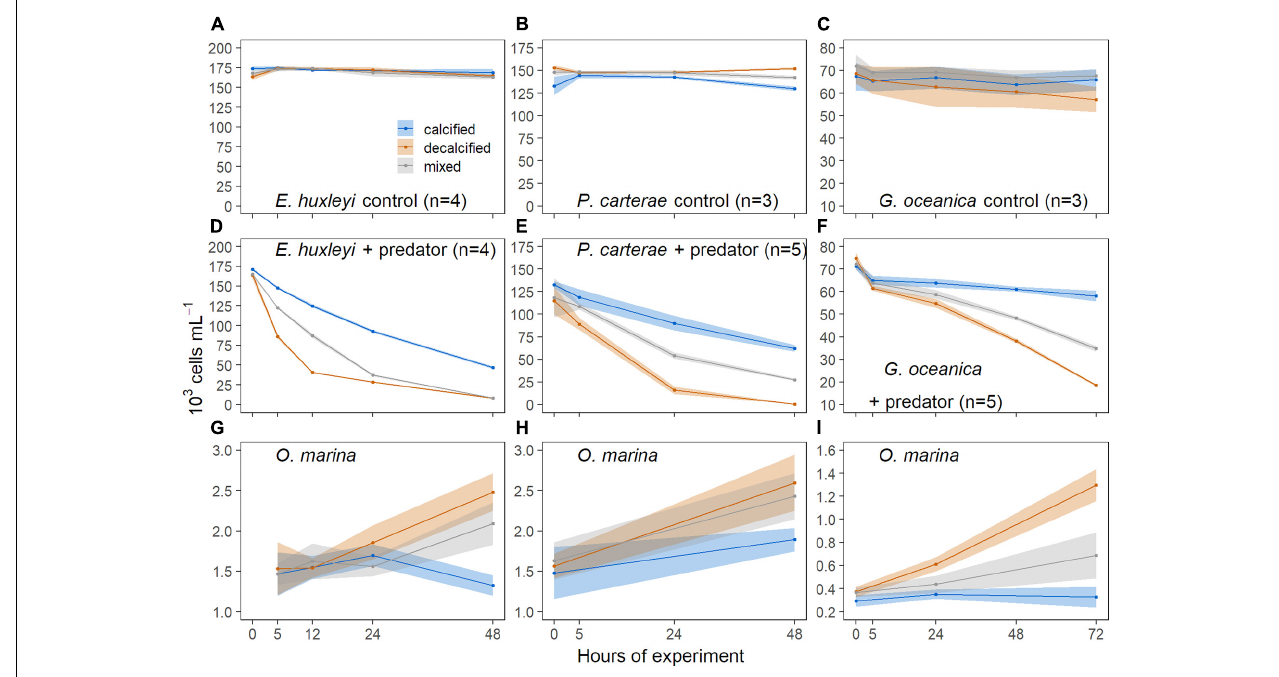
FIGURE 2 | Concentrations (mean ± SD) of E. huxleyi (A,D) , P. carterae (B,E) , G. oceanica (C,F) in the treatments without (A–C) and with (D–F) predators. Concentrations (mean ± SD) of O. marina in the respective treatments with E. huxleyi (G) , P. carterae (H) , G. oceanica (I) . Blue symbols = calcified, red = decalcified, gray = sum of calcified and decalcified cells in the mixed